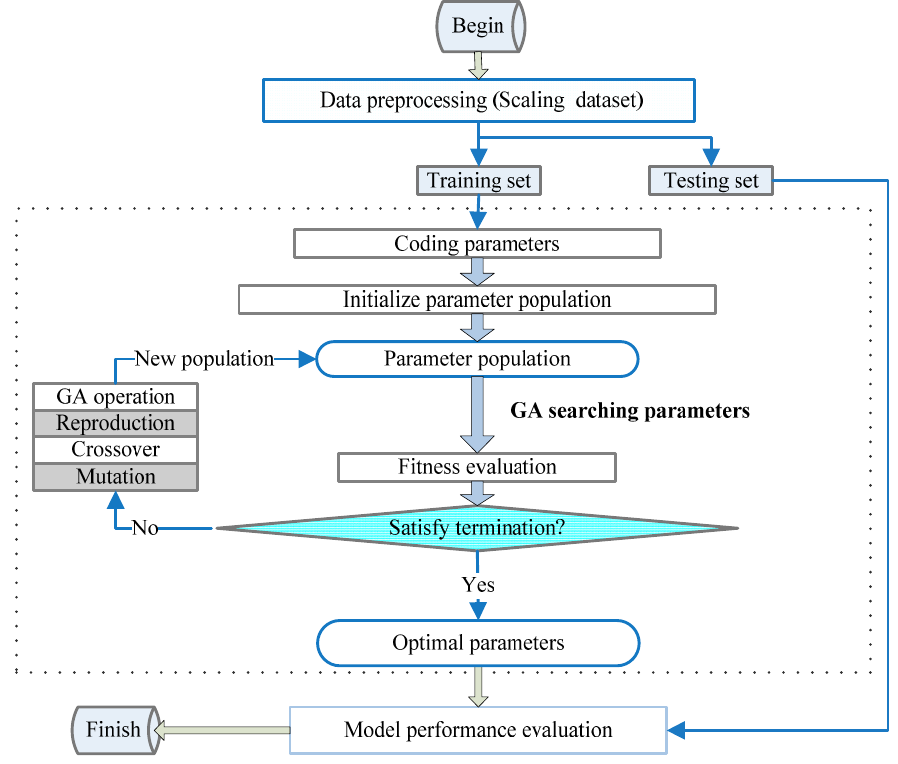
Table 1. Inverse analysis of the parameters in the constitutive equations for viscoelastic-plastic rock- like materials.